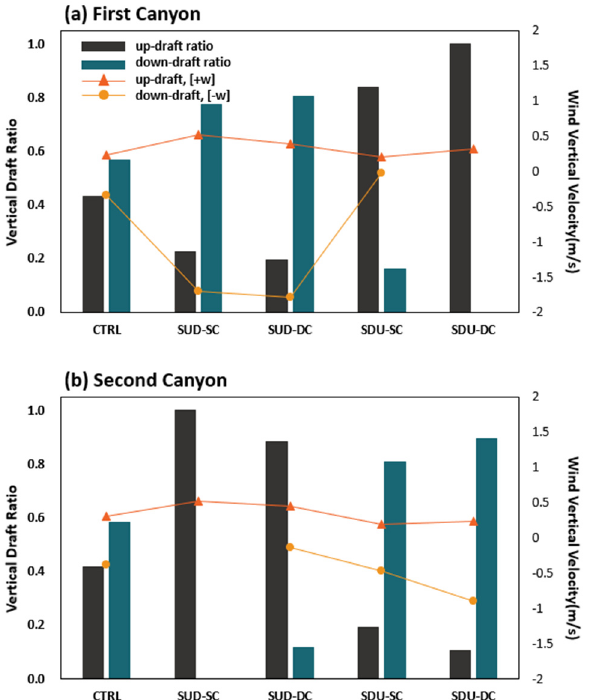
Figure 12. Changes in magnitude of the updraft and downdraft averaged over the in-canyon region with normalized vertical draft ratio in the ( a ) first canyons and ( b ) second canyons.